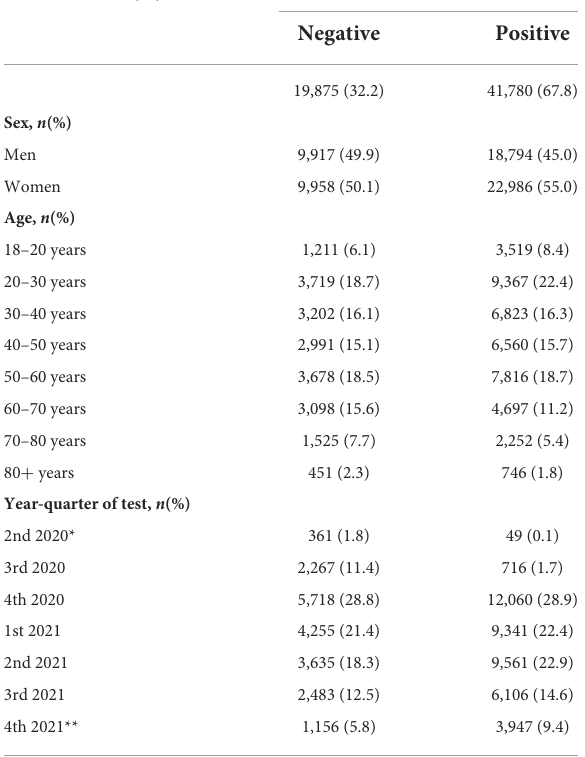
TABLE 1 Descriptives of invitees of the prevalence, risk factors and impact evaluation of post-COVID-19 condition (PRIME post-COVID)